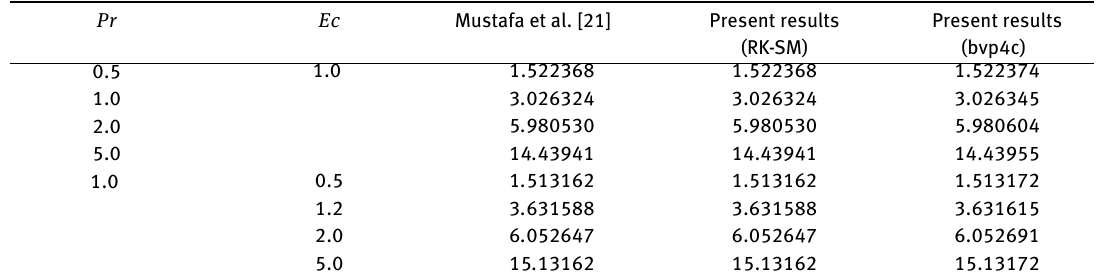
Table 1c: Comparison of present similarity solutions with the results of Mustafa et al. [21] for − θ (cid:48) (1) for various values of Pr and Ec when Ha = N b = N t = Ω T = Ω C =